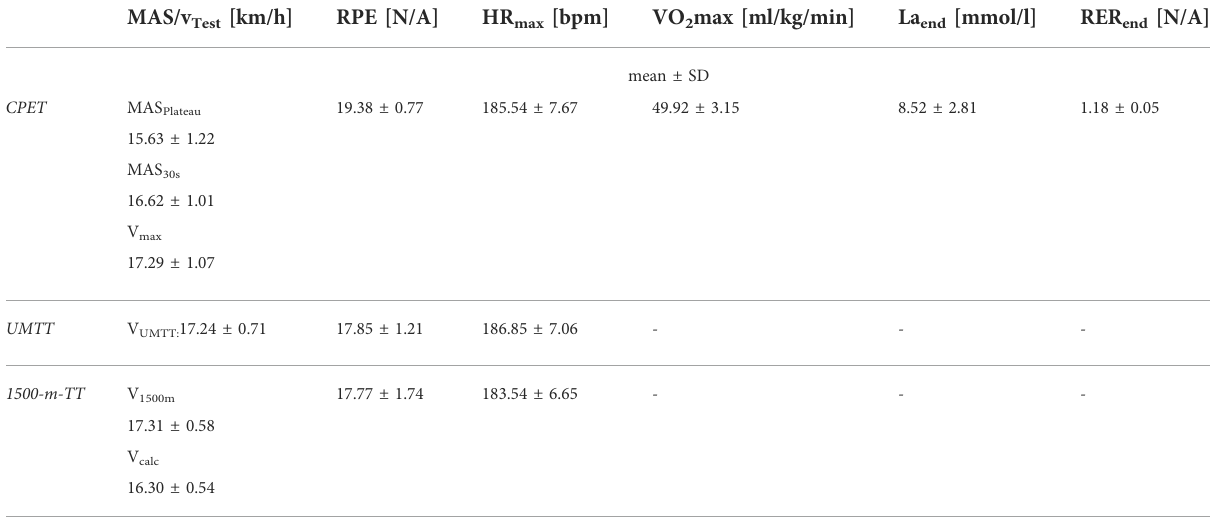
TABLE 1 Descriptive results for the CPET on the treadmill, UMTT, and 1500-m-TT. Results are presented as mean values ±SD. MAS/v Test